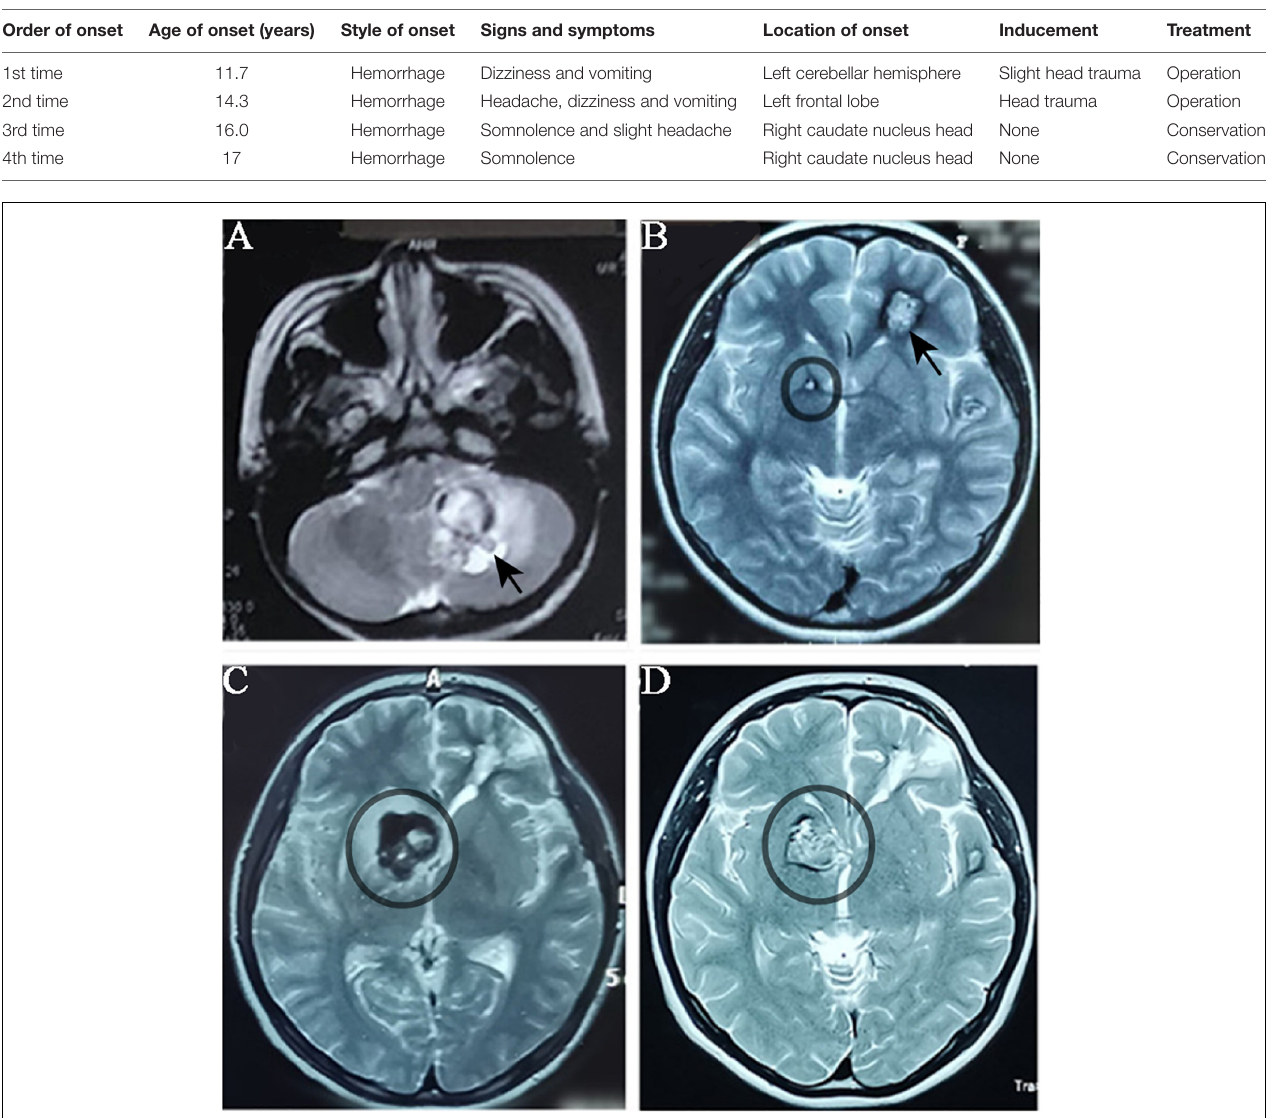
FIGURE 1 | MRI imagology of the proband’s head during the progression of CCMs. The proband had CCMs-associated haemorrhage for four times over five years. MRI images were taken when the proband patient had haemorrhage. (A) MRI (T1-weighted) detected a lesion located in the left cerebellar hemisphere (black arrow) when the proband had her first haemorrhage. (B) When the proband had her second haemorrhage, MRI (T2 weighted) showed a lesion in the left frontal lobe (which was surgically removed) and a small lesion in right basal ganglia (black circle). (C) and (D) The lesion in right basal ganglia was obviously enlarged in two years.